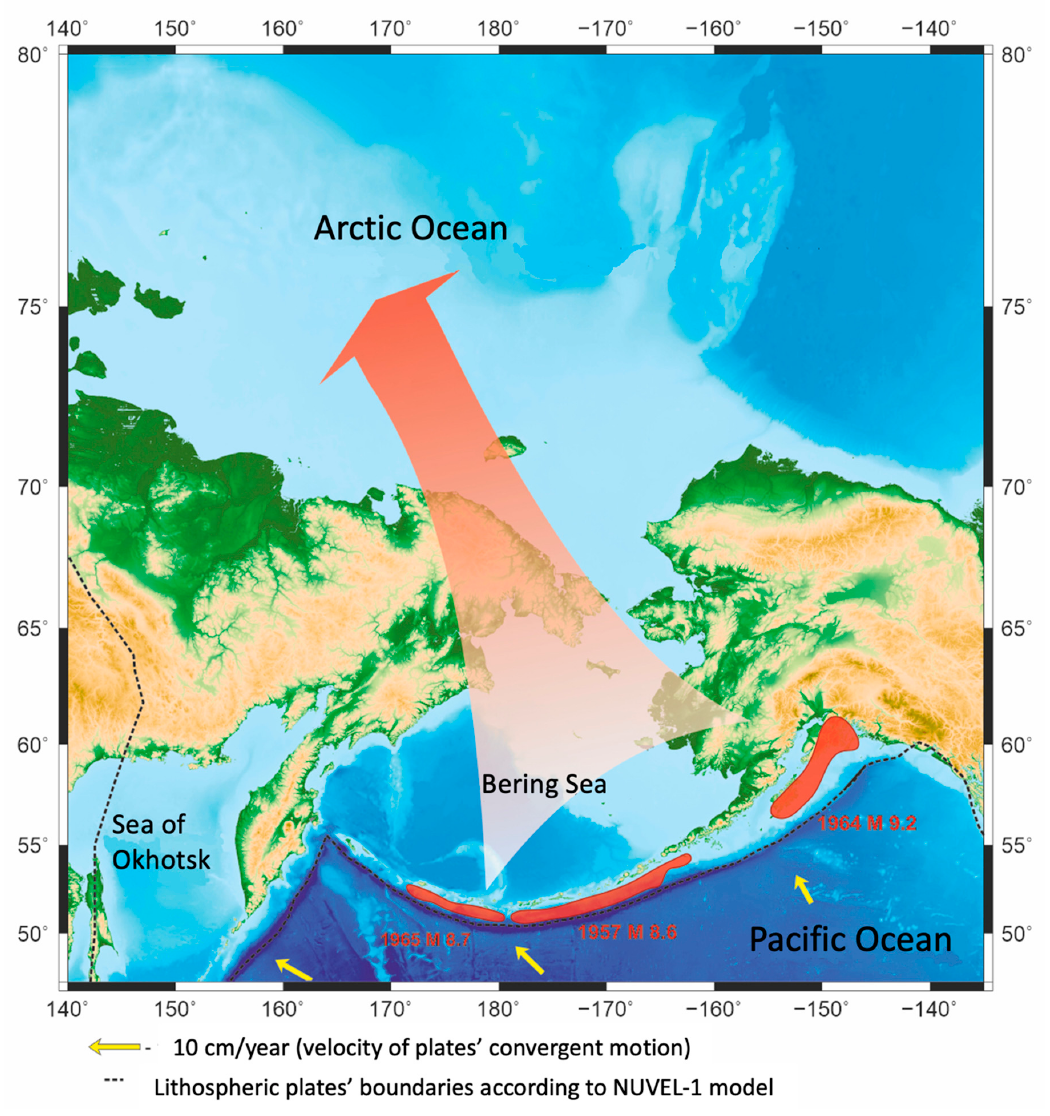
Figure 4. Locations of the great earthquakes in the Aleutian subduction zone in the second half of the 20th century and tectonic disturbance propagation towards Arctic.